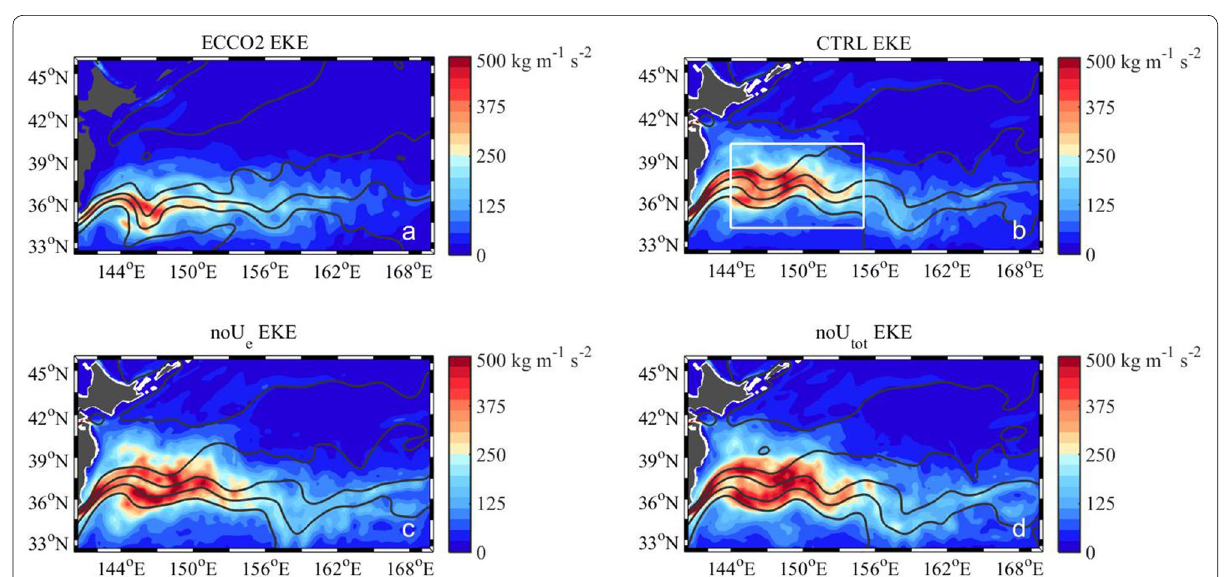
Fig. 1 The 5-year wintertime mean surface EKE based on a ECCO2, b CTRL, c noU e and d noU tot . Contour shows the mean SSH filed in the same period. The box in b denotes the Kuroshio extension region (34°–40° N, 144°–155° E)